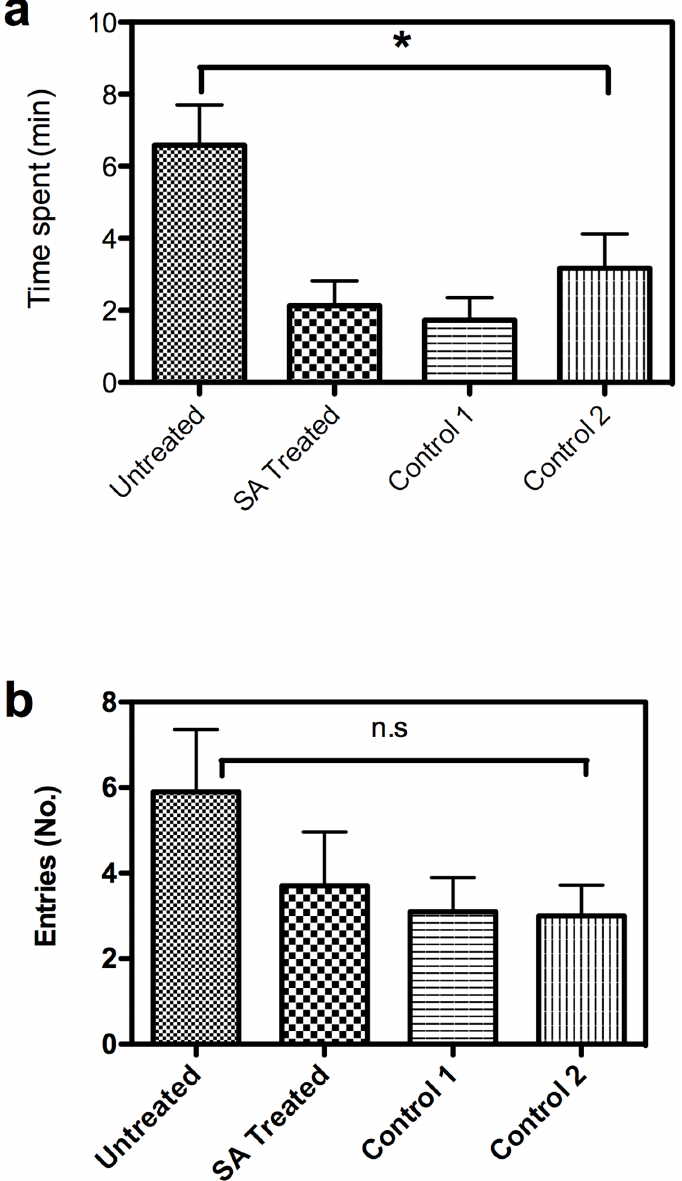
Fig 4. Behavioral response of female B . dorsalis to SA treated and untreated mango fruit (cv. Totapuri) volatiles in the olfactometer. (a) Time spent in SA treated, untreated and control arms (N = 10) (b) Number of Entries in SA treated, untreated and control arms (N = 10). The time spent and number of entries, significantly differed between untreated to treated fruit. (non-parametric Kruskal-Wallis and Dunn ’ s multiple comparison test, ( P = 0.007) [time spent]; P > 0.05 [entries]). Error bars = Standard error of mean. * Significantly different from SA treated and control arms; n.s. =